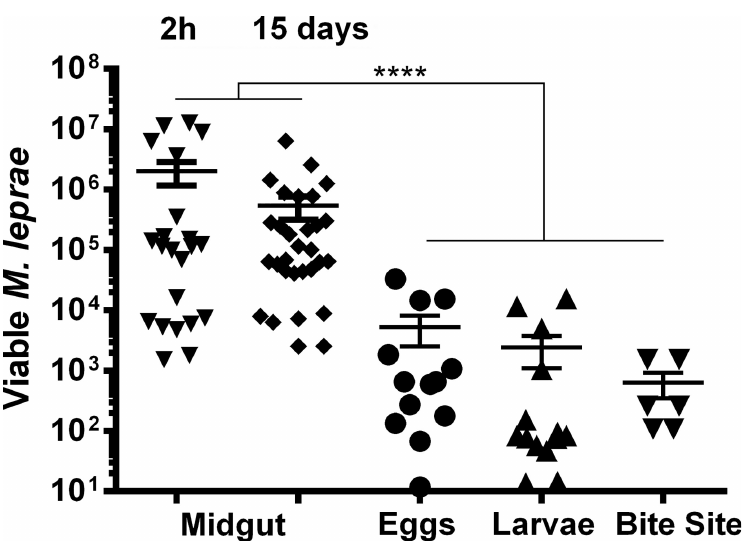
Fig 1. Viability of Mycobacterium leprae in different tick tissues after artificial infection of nearly-engorged female Amblyomma sculptum . Analysis of viability in A . sculptum midgut 2 hours (2h) and 15 days after artificial feeding, in eggs and larvae, and in skin biopsies from larval feeding sites. Each data point represents an engorged female, a pool of eggs or larvae, or a rabbit skin biopsy fragment. Levels of 16S rRNA (viable bacillus marker) and 16S rDNA ( M . leprae genome normalizer) were determined by qPCR. Through generation of qPCR standard curves by titration of known numbers of live M . leprae bacilli in different tissues, values were converted into number of genomes (viable M . leprae , y-axis). Combined results from three independent experiments, in which none of the negative control samples showed detectable signal; ���� indicates p < 0.0001 by Dunn’s multiple comparisons test.